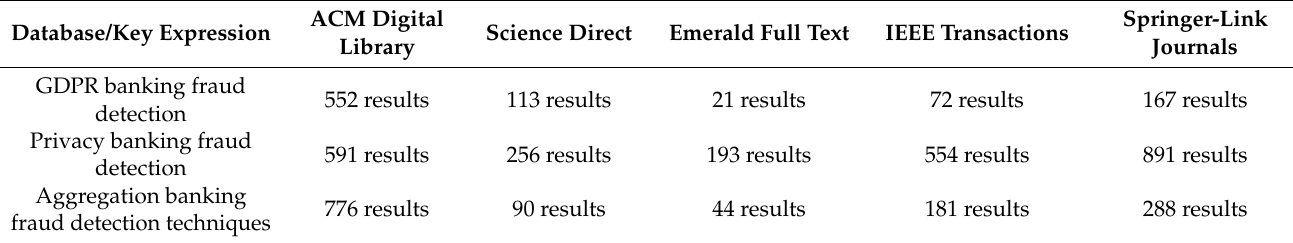
Table 1. Articles on topic—number of results adjusted by key phrases and